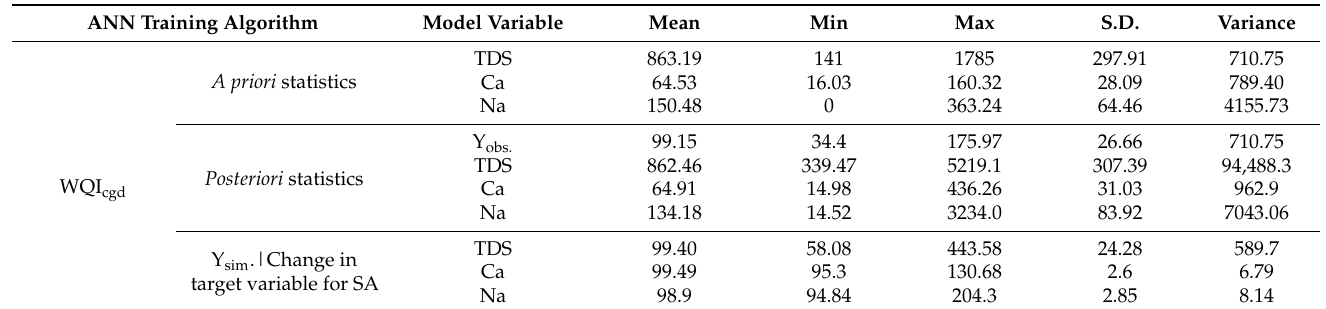
Table 7. A priori and posteriori statistics of the statistical distribution of the ANN CGD training algorithm-based MLR model.